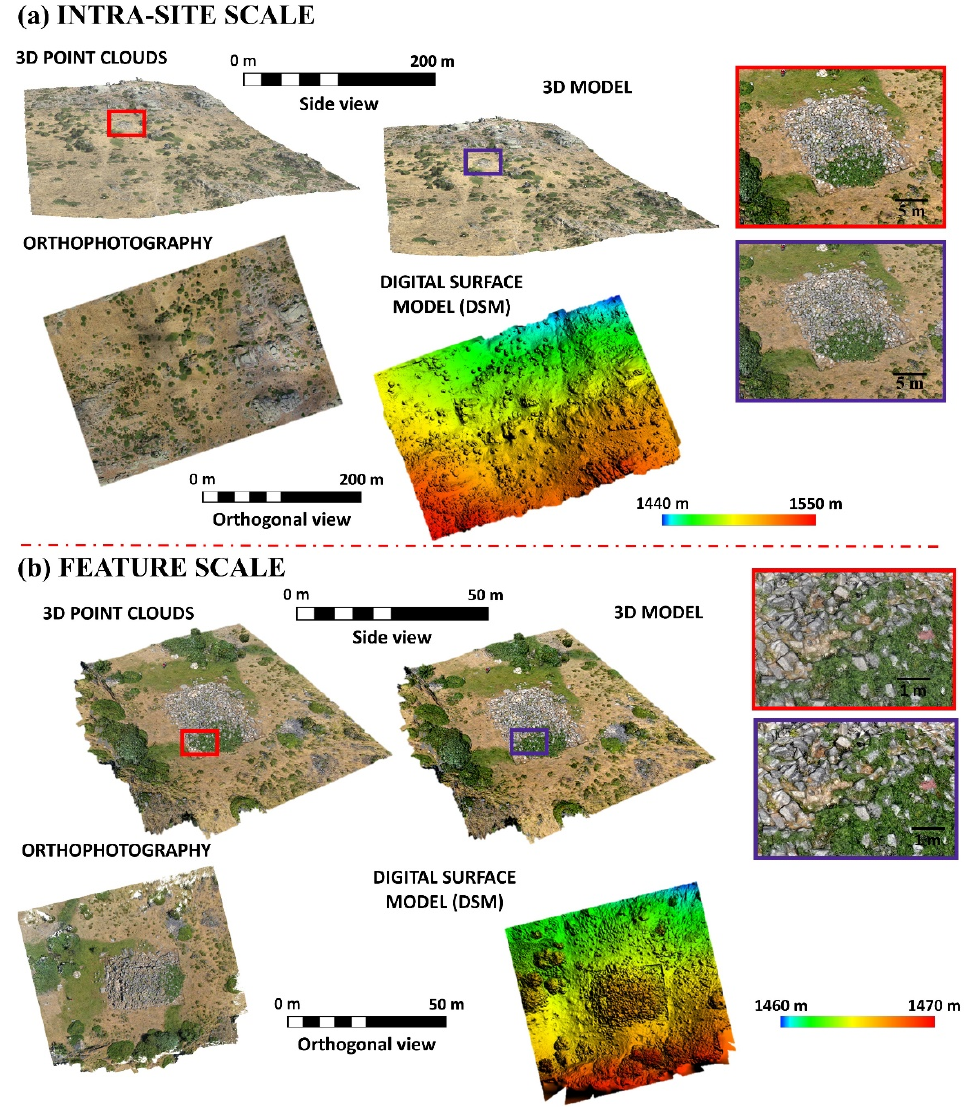
Figure 4. ( a ) Results of the parallel photographic shooting protocol (Figure 3a). ( b ) Results of the oblique/convergent photographic shooting protocol (Figure 3b).